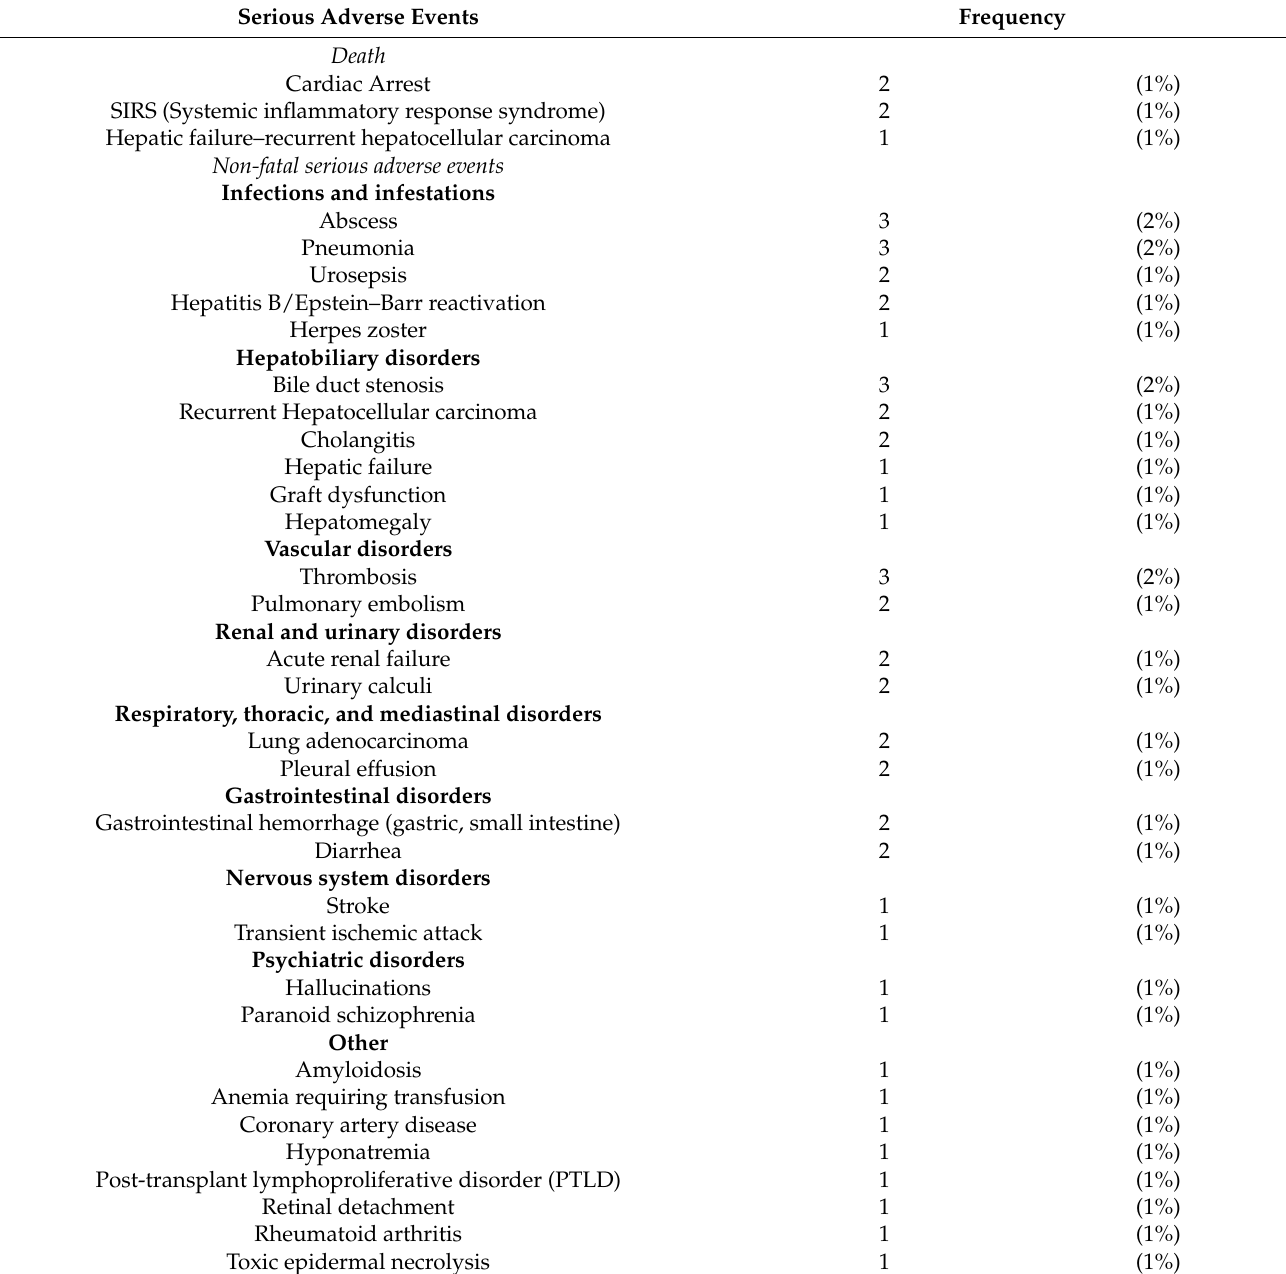
Table 6. Serious adverse events: includes all events which lead to death, hospitalization, or disability throughout the study period, N (% of patients). MedDRA (Medical Dictionary for Regulatory Activities) preferred